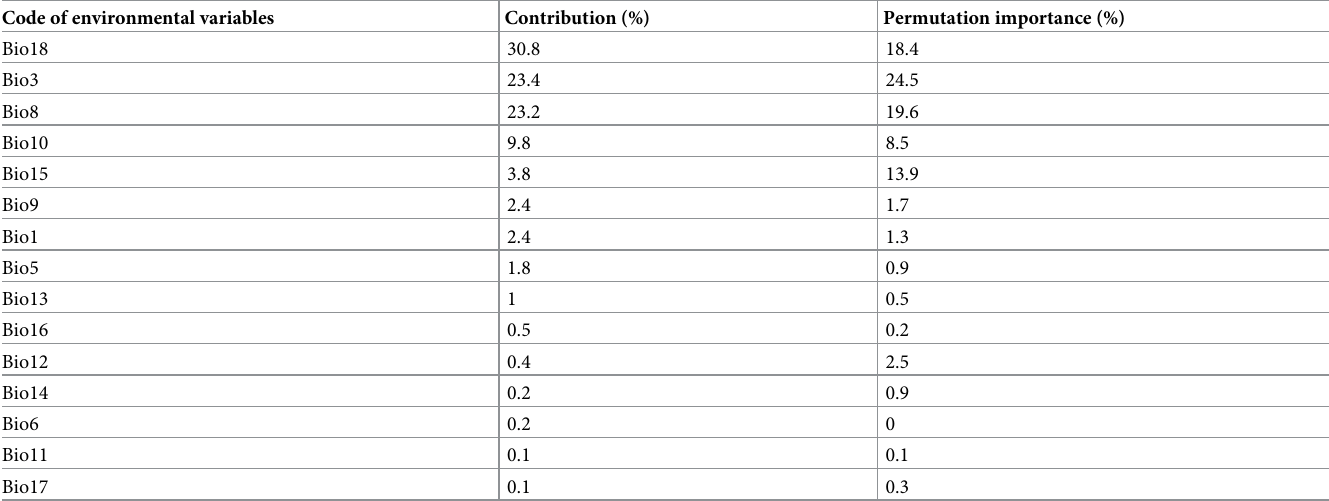
Table 3. Contribution and ranking importance of the environmental variables.